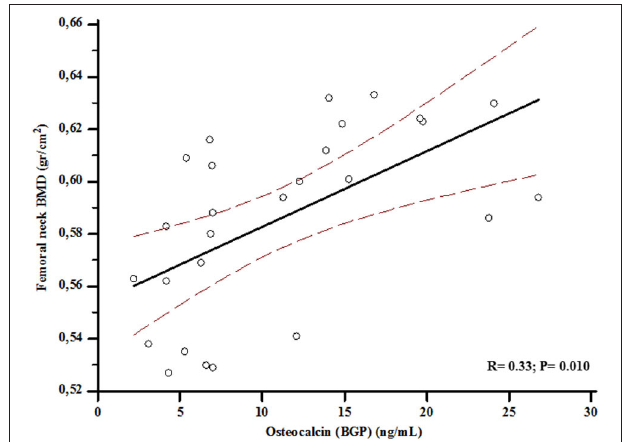
FIGURE 3 | Association between levels of osteocalcin (BGP) and bone mineral density (BMD) at femoral neck at baseline.